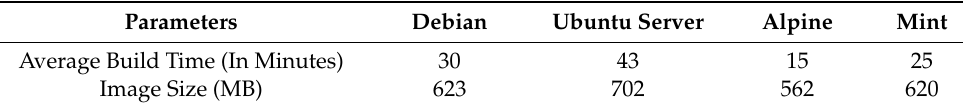
Table 2. The NIDS agent’s average build time and image size, based on the Snort sensor, are based on its base